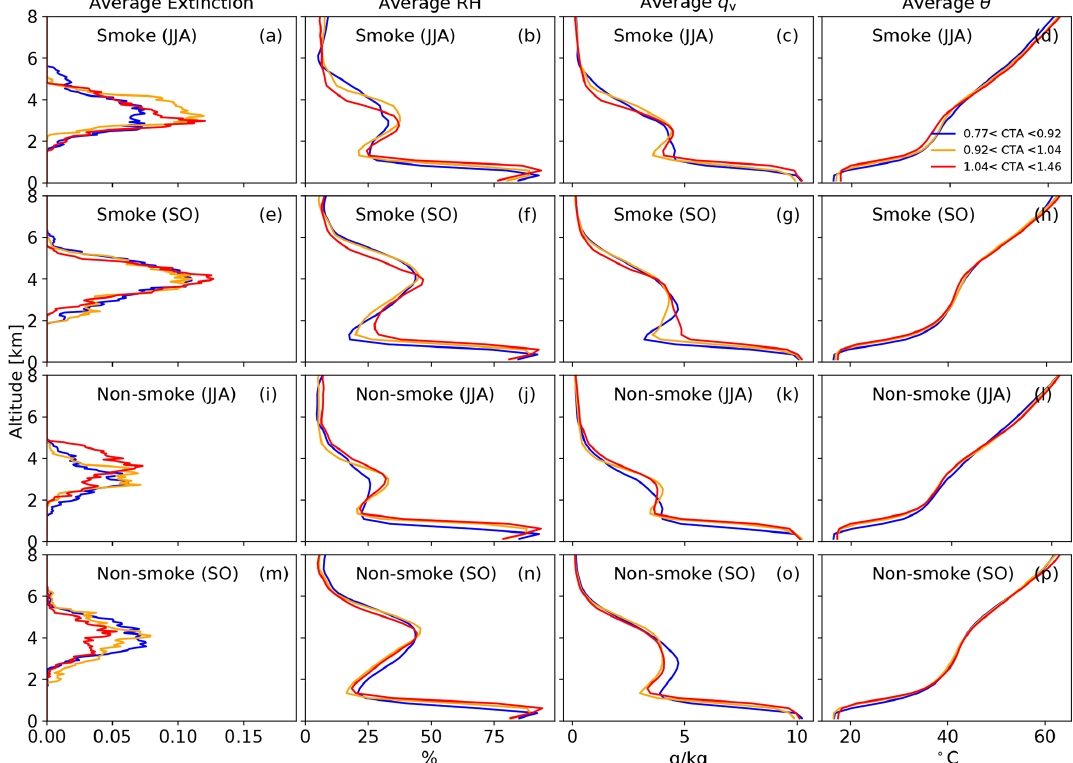
Figure A5. Mean profiles of aerosol extinction, relative humidity (RH), specific humidity ( q v ), and potential temperature ( θ ) for the smoke cases June–July–August (JJA) and September–October (SO). Cases were subdivided into three intervals as a function of the CTA